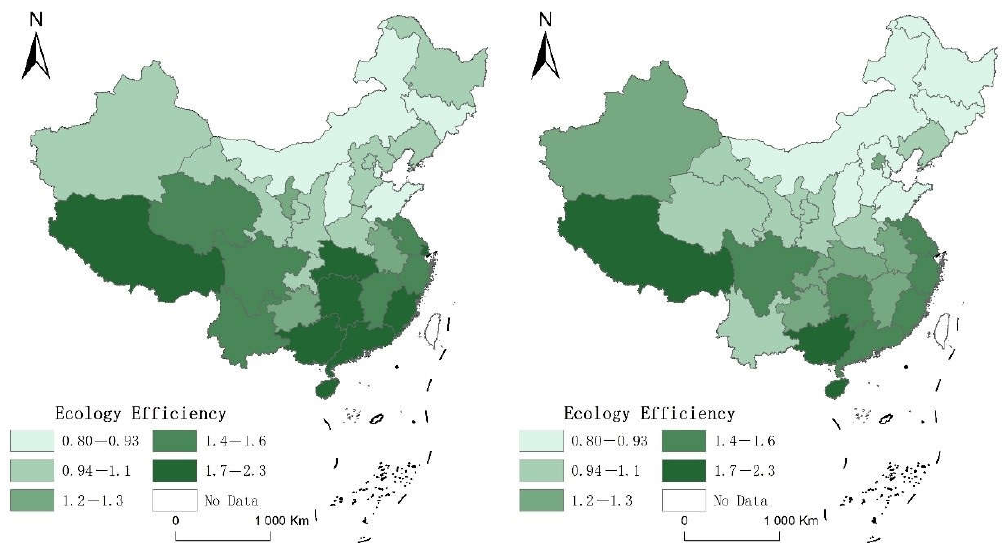
Figure 1. The spatiotemporal evolution pattern of ecological efficiency.